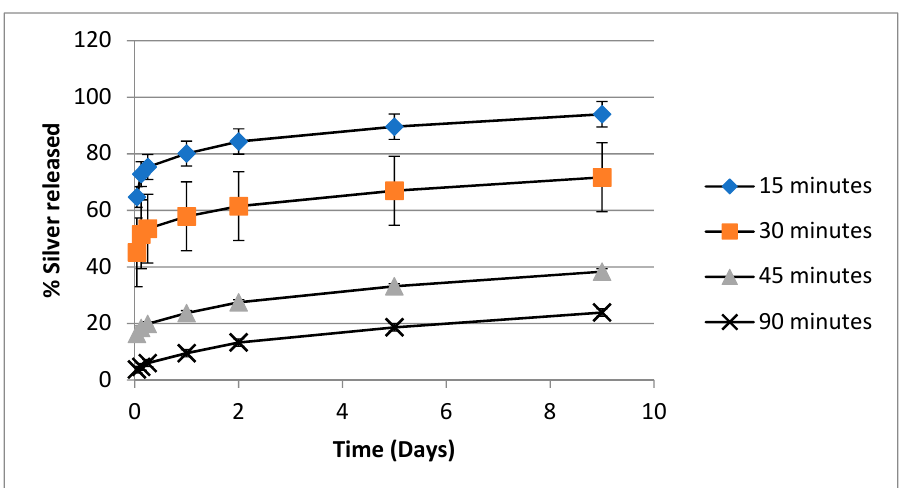
Figure 8. In vitro release of silver from PVA/silver nitrate films in water as a function of heating time after films with 5% silver nitrate loading have been heated at 140 °C.